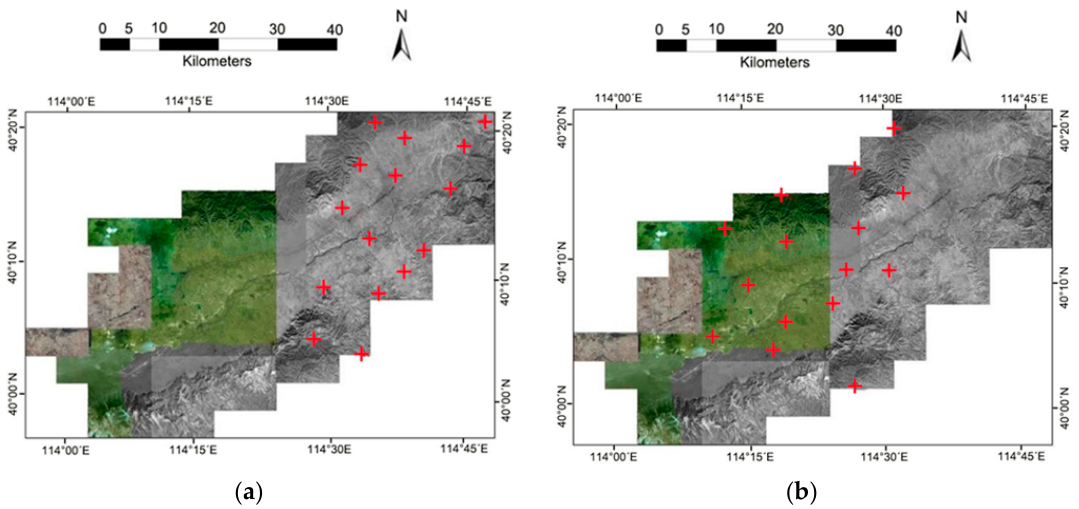
Figure 5. The spatial distribution of the validation GCPs located on the base image: ( a ) the validation GCPs were used for validating images a1/b1/ab1; ( b ) the validation GCPs were used for validating a2/b2/ab2. Table 3. The RMSEs of 15 validation GCPs for validating rectified images a1/b1/ab1 and a2/b2/ab2 (unit: meter).